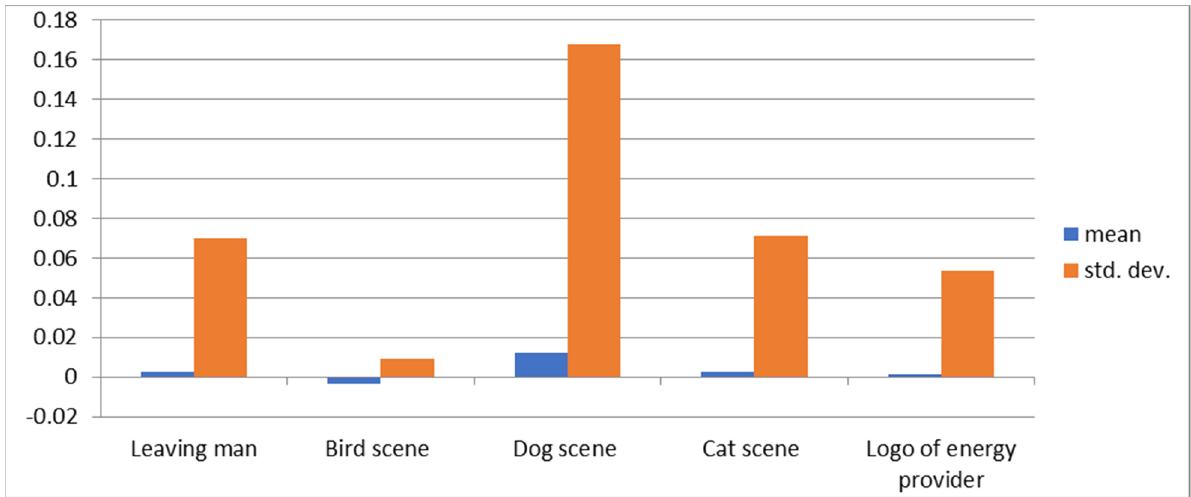
Figure 7. Standard deviations of the normalized male and female engagement indices for the “turn off power, turn on savings” media message.